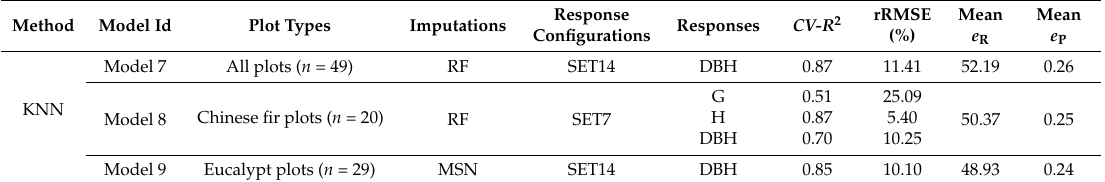
Figure 5. Reynolds error index for diameter distributions of different forest types by MSN ( a ) and RF ( b ) imputations of KNN with 15 response configurations. The response configurations in ascending order of the mean e R values of all plots; e R = Reynolds error index. Table 8. The optimal response configurations and imputation methods for KNN imputed diameter distributions of different forest types and corresponding cross-validation results of the R 2 and rRMSE for selected responses. e R = Reynolds error index; e P = Packal é n error